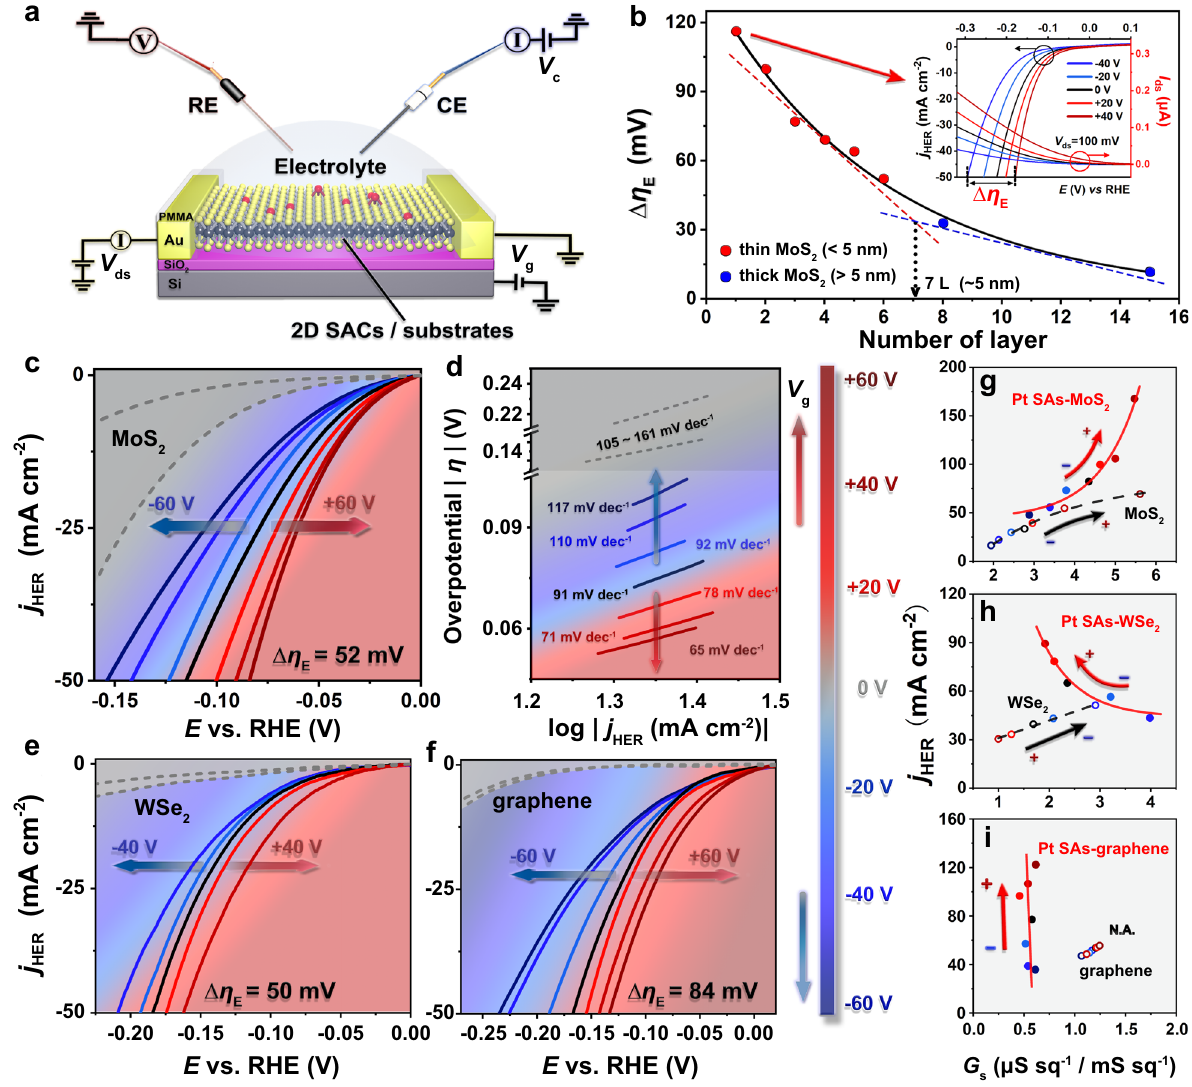
Fig. 2 In situ electronic/electrochemical investigations on Pt-based SACs for HER under oriented external electric fi eld (OEEF) regulation. a Schematic diagram of an on-chip four-electrode microcell for electronic/electrochemical measurements, OEEFs were introduced via vertically applied back gate voltage ( V g ) through a dielectric layer. b Layer dependence on the HER activity modulation (tunable potential range, Δ η E ) in pristine 2D MoS 2 (n-type semiconductor). Inset: HER polarization curves and in situ drain-source current of monolayer MoS 2 under OEEF regulation, with V ds = 100 mV and V g from − 40 V to + 40 V. c , d HER polarization curves ( c ) and Tafel curves ( d ) of Pt SAs-MoS 2 in response to OEEFs. e , f HER polarization curves of Pt SAs-WSe 2 ( e ) and Pt SAs-graphene ( f ) in response to OEEFs. The two gray dashed lines in c – f represent the tunable HER activity of pristine 2D substrates under OEEF regulation. The color bar in c – f shows the direction and scope of V g . g – i Correlations between electrochemical current density ( j HER ) and in situ sheet conductance ( G s ) of Pt SAs-MoS 2 ( g ), Pt SAs-WSe 2 ( h ), Pt SAs-graphene ( i ), and pristine 2D substrates under OEEF regulation. The arrows in g – i indicate the OEEF-modulation directions of HER performance optimization. Note that in g – i the unit of abscissa is μ S sq − 1 for Pt SAs-MoS 2 and Pt SAs-WSe 2 , while mS sq − 1 for Pt SAs-graphene, and j HER in g – i were extracted at the potentials (vs. RHE) of: − 0.15 V for Pt SAs-MoS 2 , − 0.2 V for MoS 2 , − 0.2 V for Pt